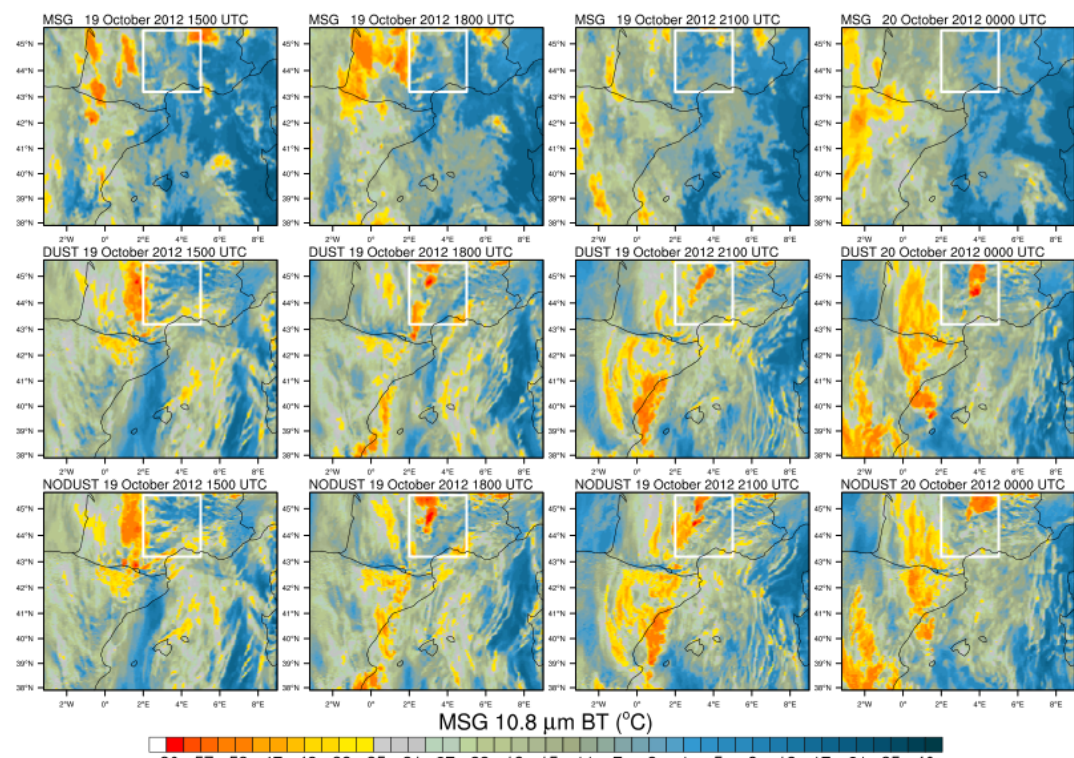
Figure 12. Same as Fig. 11 but for the afternoon of 19